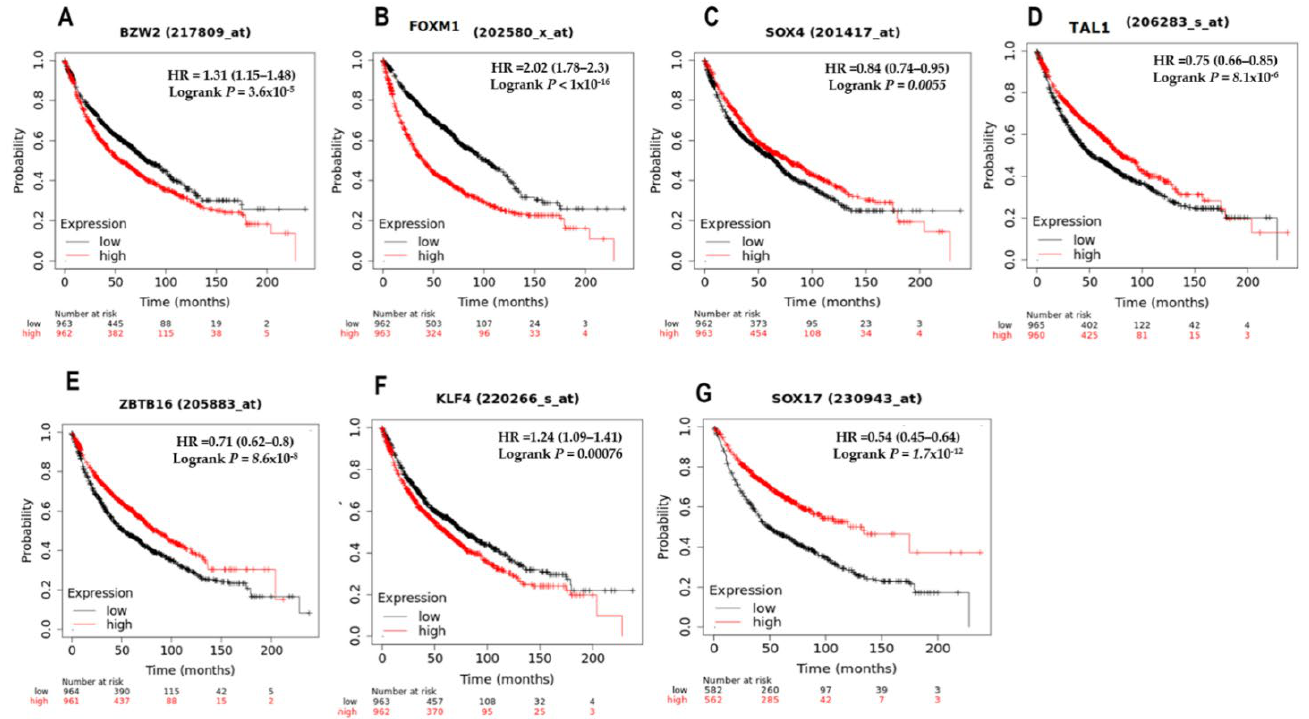
Figure 8. Transcriptional regulatory network of the top seven deregulated transcription factors (squares) over the other nineteen frequently dysregulated transcription factors (circles) in every lung cancer type (( A ). NSCLC and ( A ). SCLC). In blue are the downregulated TFs, and in red are the upregulated TFs.